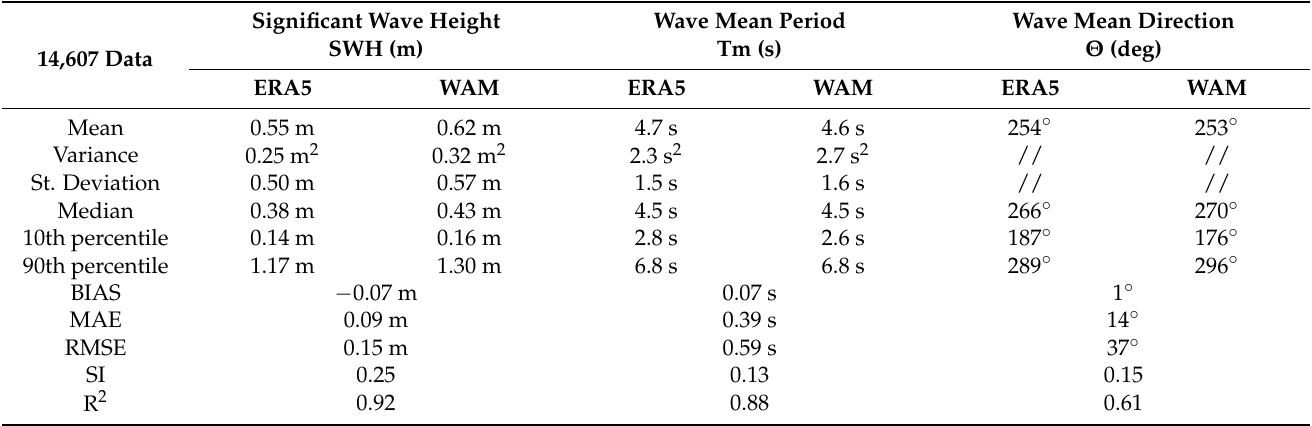
Figure 4. Dataset 27 February 1999–5 April 2008, time step of 6 h. Comparison between ERA5 and WAM hindcast at Cetraro. Scatter plots of SWH ( a ) and Tm ( b ). Green lines represent the quantile–quantile plots, black lines the bisector, and red lines the least-square best fits. Table 2. Dataset 1 January 2009–31 December 2019, time step of 6 h. Comparison between ERA5 and WAM at Cetraro. Statistics parameters and error metrics for SWH, Tm, and θ . Non-significant values are identified with “//”.